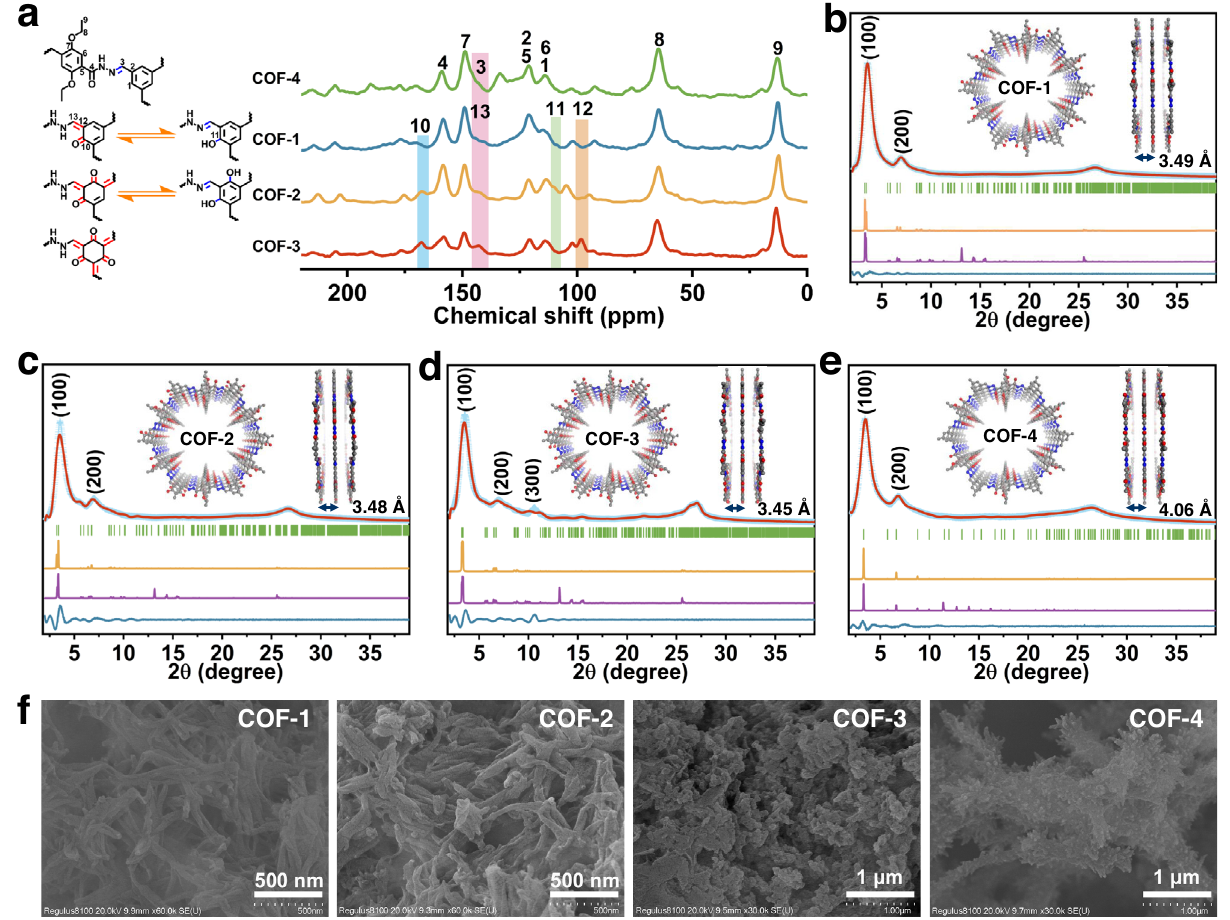
Fig. 2 | Chemical structure and characterization of COFs. a Solid-state 13 C CP/ MAS NMR spectra of COF-1, COF-2, COF-3, and COF-4. b – e Experimental and simulated PXRD patterns of COF-1, COF-2, COF-3, and COF-4 with corresponding Pawleyre fi nements(red),simulatedeclipsedAAstackingresults(khaki),simulated staggered AB stacking results (purple), and Bragg positions (green) showing that